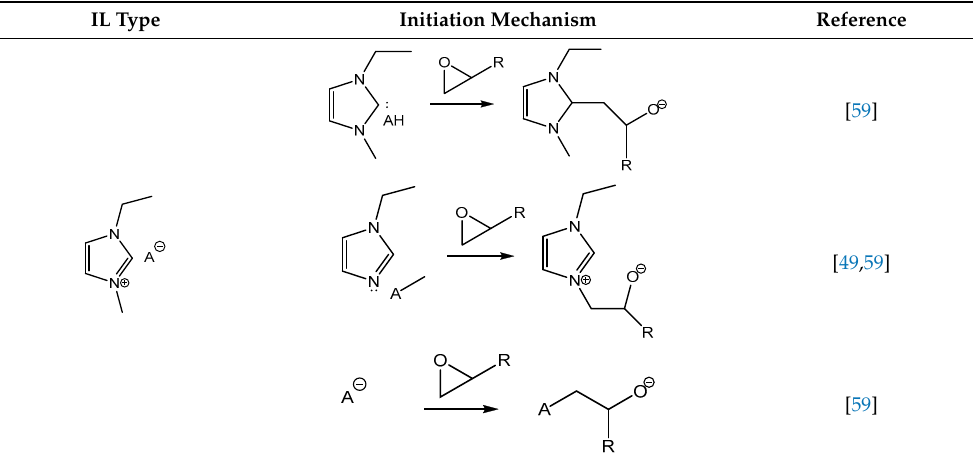
Table 1. Proposed initiation mechanisms for curing epoxy resins using ILs.